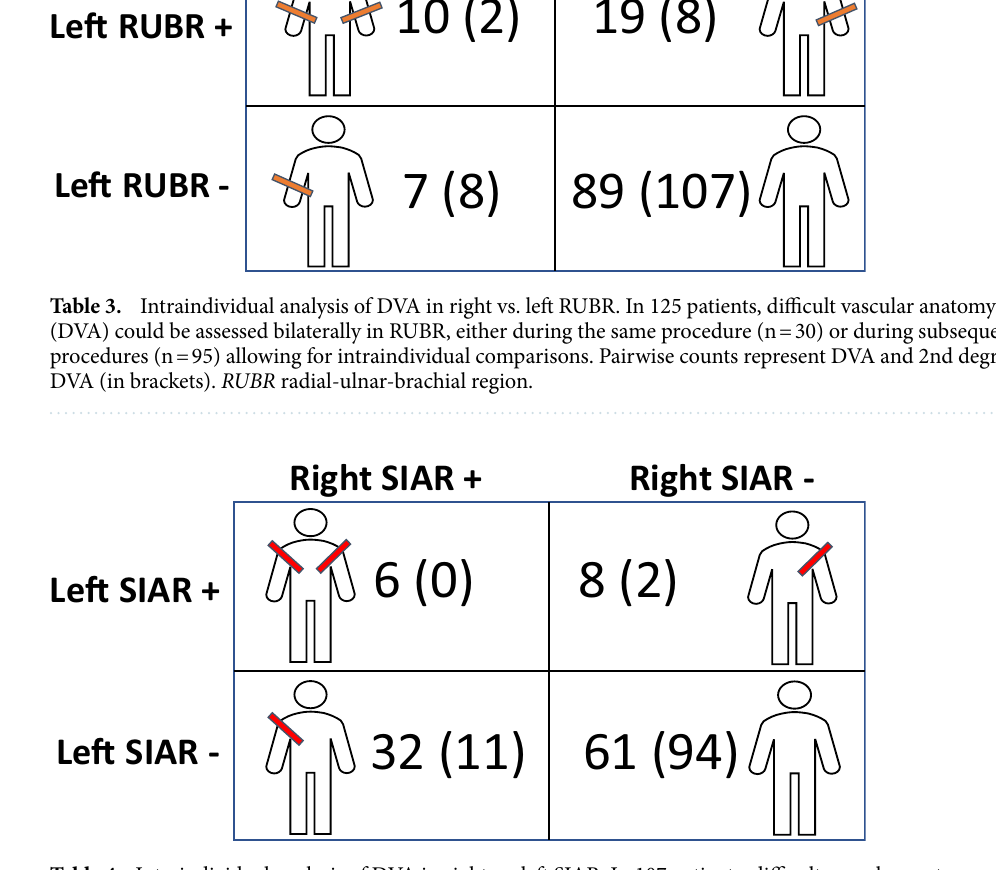
Table 4. Intraindividual analysis of DVA in right vs. left SIAR. In 107 patients, difficult vascular anatomy (DVA) could be assessed bilaterally in SIAR, either during the same procedure (n = 13) or during subsequent procedures (n = 94) allowing for intraindividual comparisons. Pairwise counts represent DVA and 2nd degree DVA (in brackets). SIAR subclavian-innominate-aortic